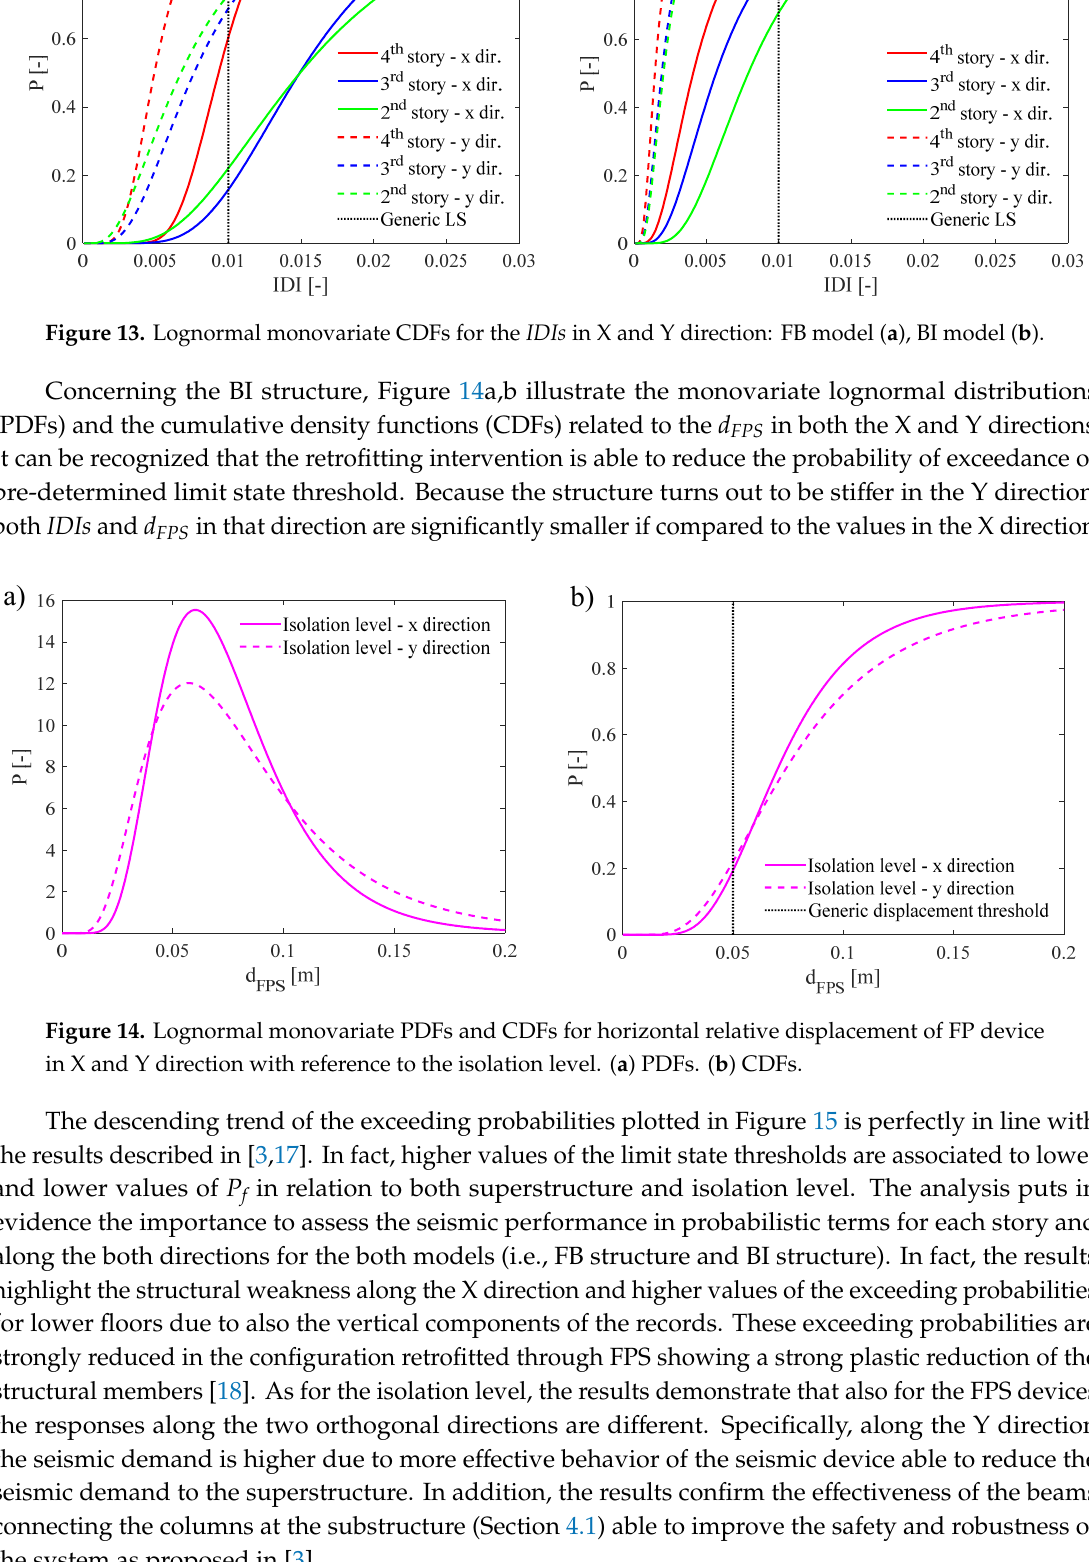
Figure 12. Lognormal monovariate PDFs for the IDIs in X and Y direction: FB model ( a ), BI model ( b ).